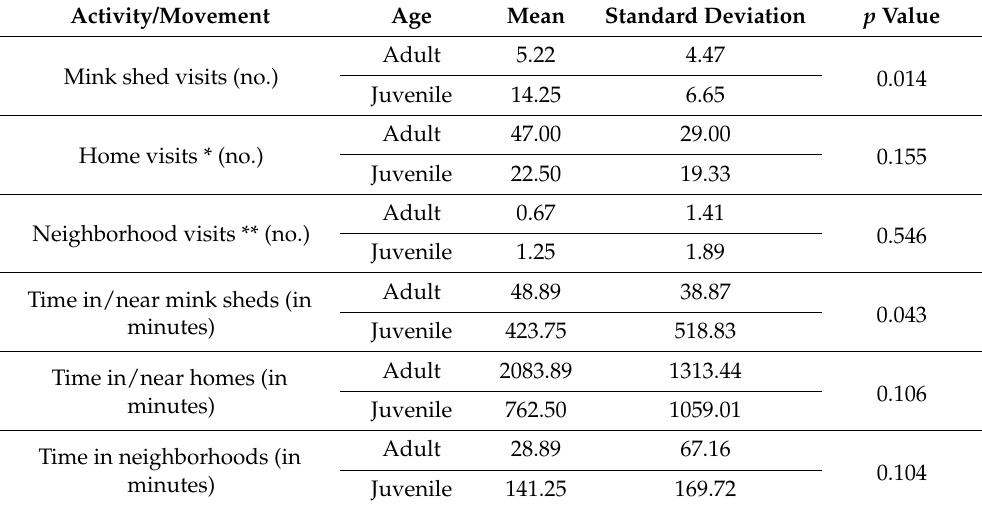
Table 2. Comparison of the mean activity and movement of adult (n = 9) and juvenile cats (n = 4) near SARS-CoV-2-infected mink